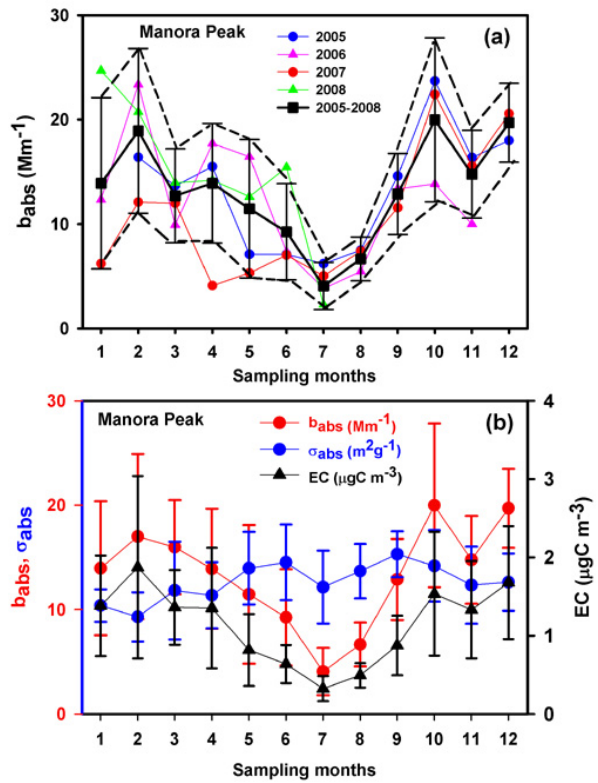
Fig. 8. (a) The temporal variability of average b abs for the years 2005, 2006, 2007 and 2008. Data points shown by filled squares re- fer to monthly average values of b abs for four years (b) The monthly average values of b abs , σ abs , and EC mass